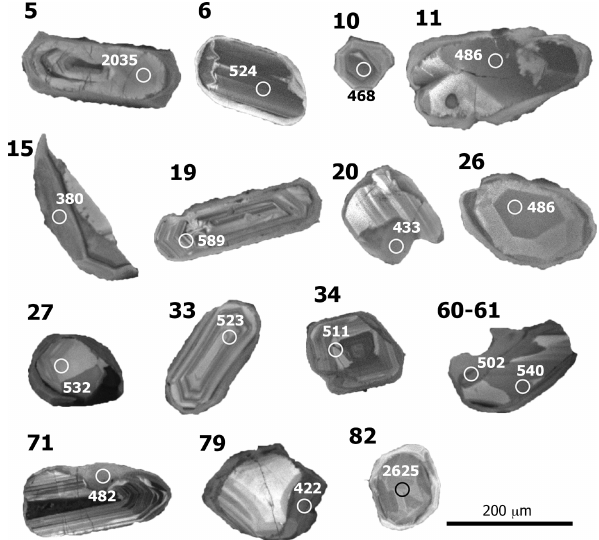
Figure 6. CL images with the location of the analyzed spots for selected zircon